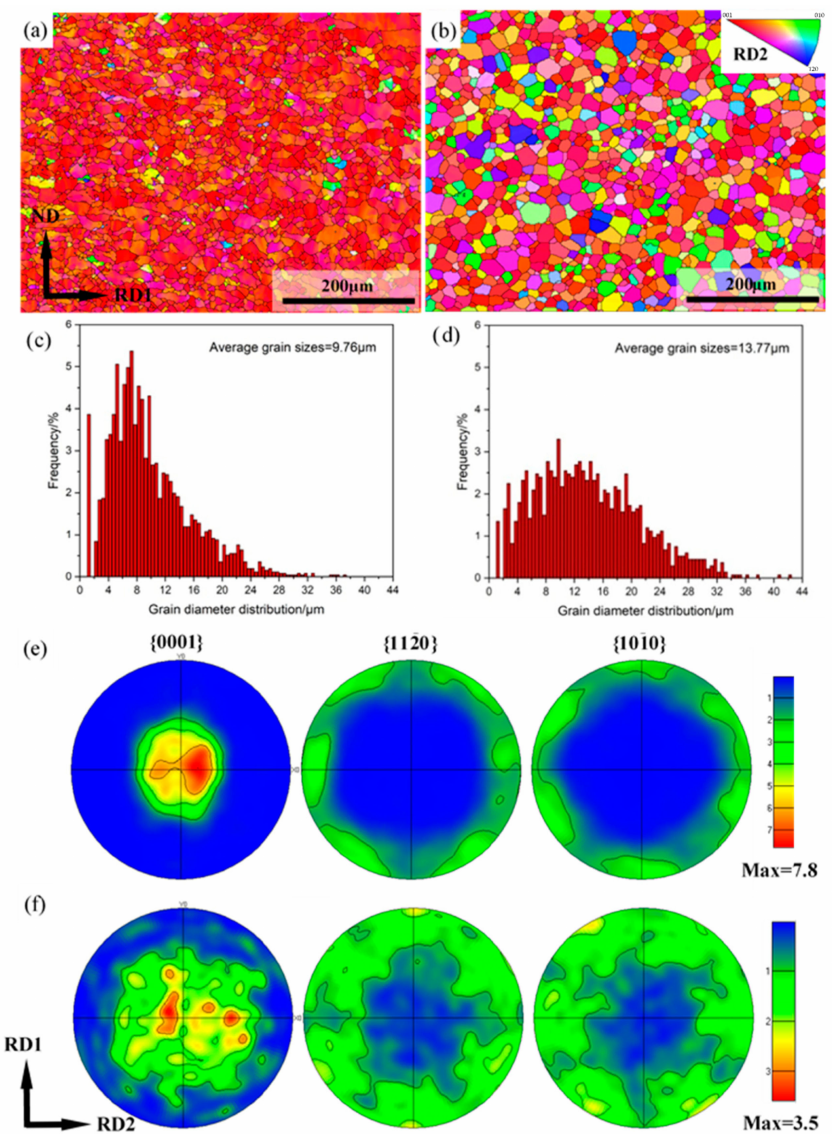
Figure 13. EBSD IPF maps of ( a ) as-rolled and ( b ) as-annealed; grain size distributions of ( c ) as-rolled and ( d ) as-annealed; (0001), (11-20), and (10-10) pole figures of ( e ) as-rolled and ( f ) as-annealed Mg-3Y sheets. Observation along RD2 was applied to IPF